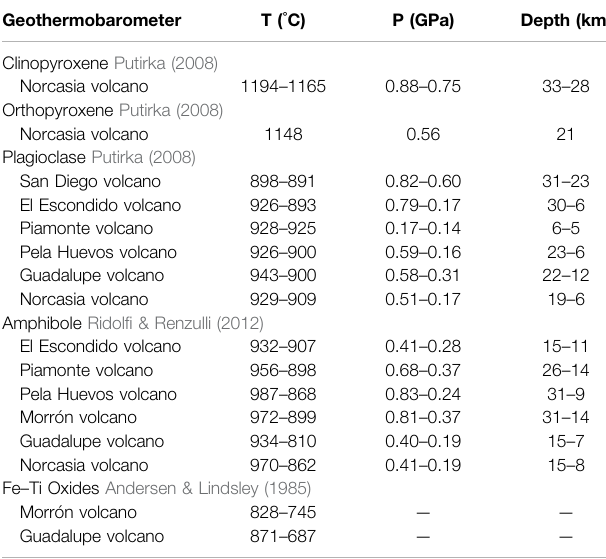
TABLE 5 | Estimated temperature, pressure, and depth crystallization values of the mineral phases that were identi fi ed at the Samaná monogenetic volcanic fi